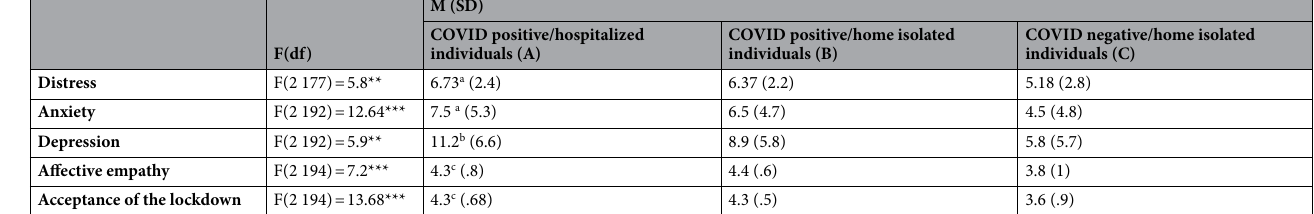
Table 3. Results of the ANOVA. * p < .05. ** p < .01, *** p < .001. a = Significant Post-Hoc comparisons: A